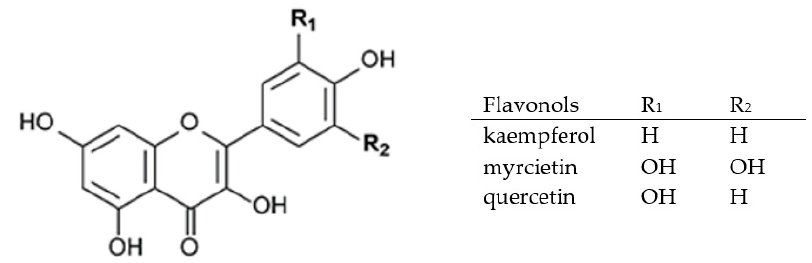
Figure 8. Structure of flavonols [158]. Reproduced with permission from [Drake V.J.], [Linus Pauling Institute]; published by [Oregon State University], 2005.